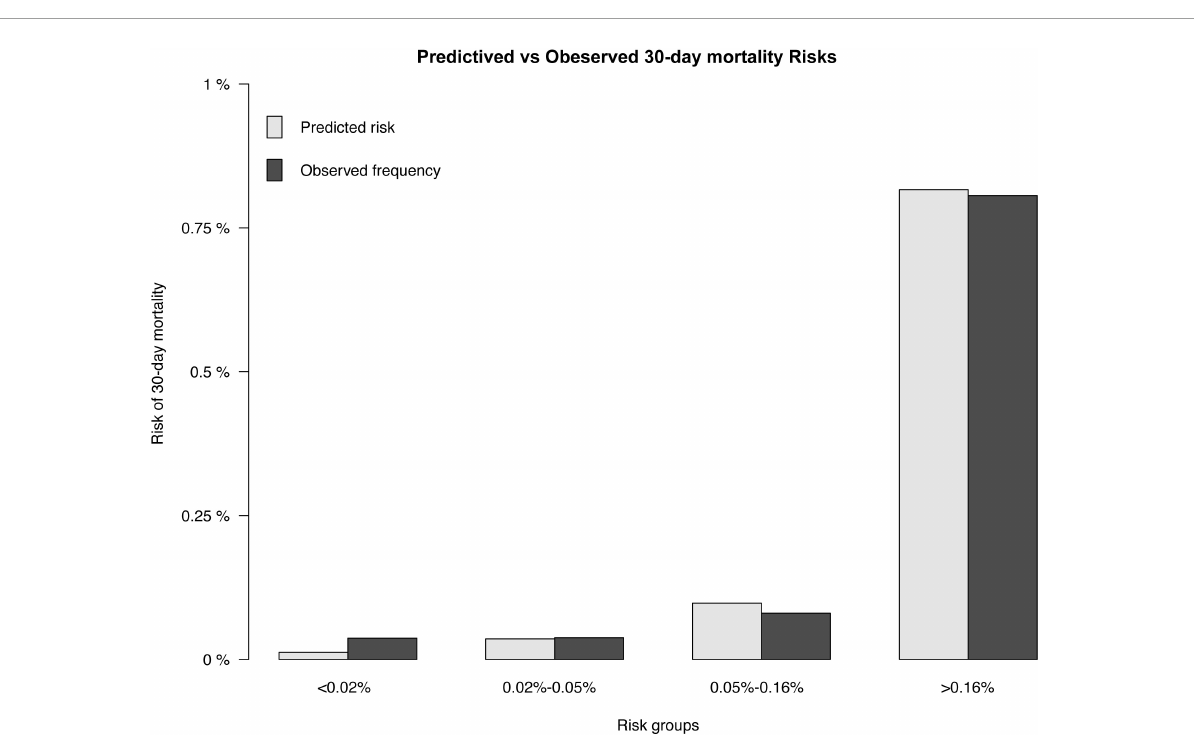
FIGURE3 Predicted and observed 30-day mortality risk. The predicted (gray) and observed (black) risk of 30-day mortality for patients following